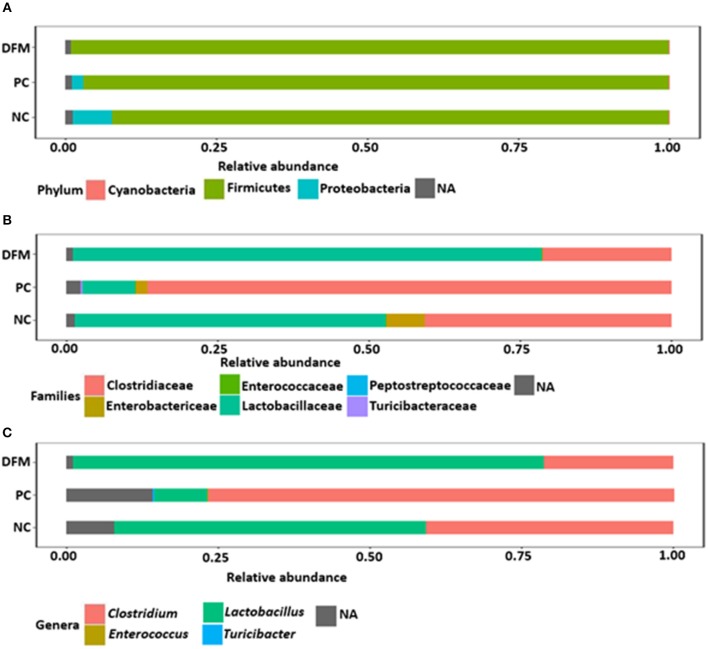
Relative abundance of different phyla (A), families (B) and genera (C) in different treatment groups (NC, PC, and DFM). NA refers to those reads that were not assigned to the respective taxonomic levels.